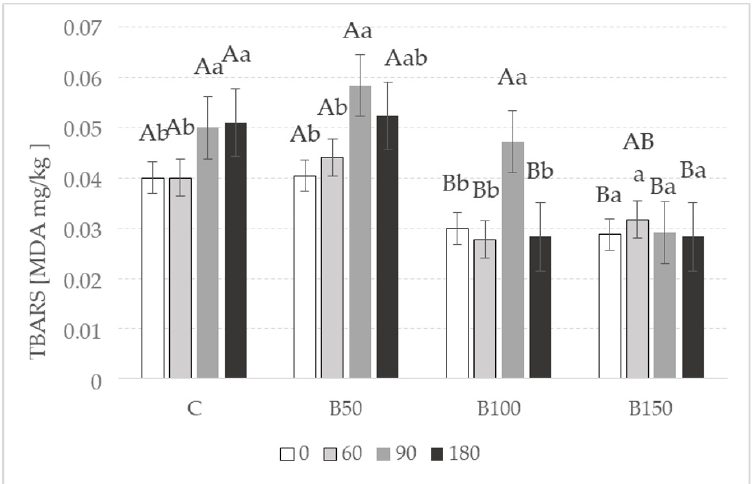
Figure 3. Amount of secondary lipid oxidation products (TBARS) in canned meat samples fortified with the extract of black currant leaves during 180 days of storage (4 °C). C—control; B50—black currant leaves 50 mg/kg; B100—black currant leaves 100 mg/kg; B150—black currant leaves 150 mg/kg. Means with different capital letters are significantly different ( p < 0.05) on the day of the study. Means with different small letters are significantly different ( p < 0.05) for a single variant during the storage time. Results are presented as mean ± SD.